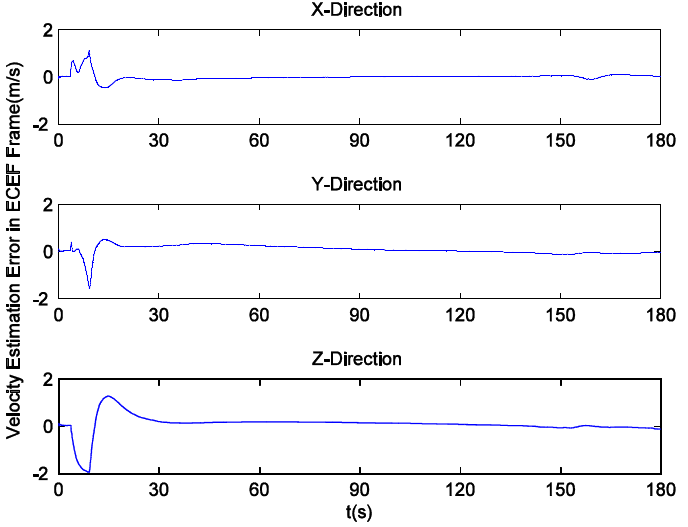
Figure 21. GPS/INS (tight integration, traditional navigation filter) velocity estimation errors.